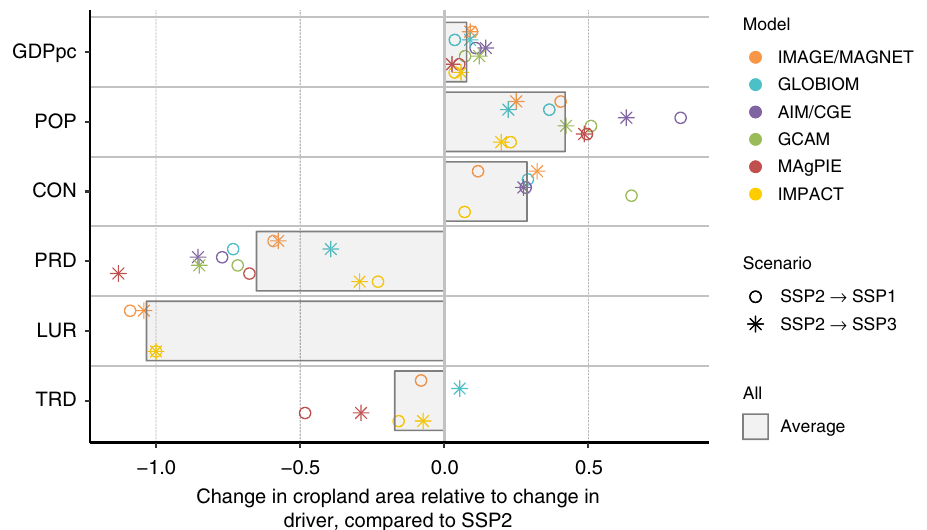
Fig. 4 Elasticity of cropland area change to a change in scenario driver. The elasticity indicates how a relative change in the driver, e.g., population, translates to a relative change in output variables, in this case cropland area. For example, we see that if PRD would increase in GCAM by 10%, cropland area would be decreased by about 8% (elasticity of − 0.8), whereas the same change of 10% in PRD in IMPACT would lead to a reduction of about only 2% (elasticity of − 0.2). Data points per model and scenario show average across fi nal and individual effects. Drivers ’ abbreviations: CON: consumption preference, GDPpc: economic development, LUR: land-use change regulation, POP: population, PRD: agricultural productivity growth, TRD: trade development. We excluded data points of which the underlying changes were very small